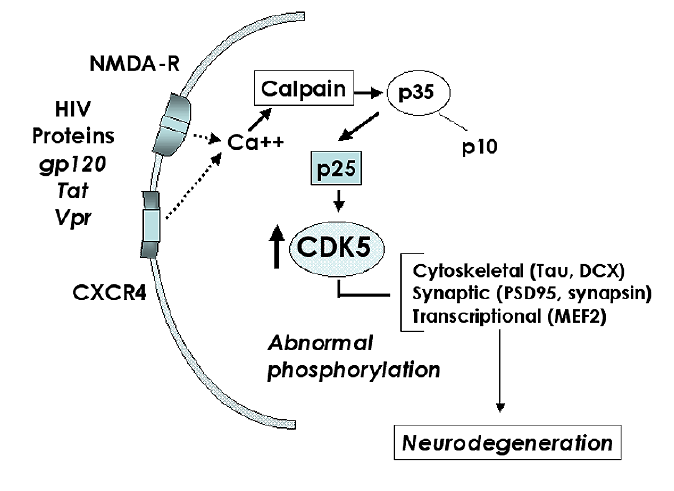
Figure 6. Potential mechanisms of HIV-induced neurodegeneration mediated by hyperactivation of CDK5. Activation of cell surface receptors by HIV proteins or cellular neurotoxins causes calcium influx, which might activate calpain and result in p35 cleavage into p25, which in turn hyperactivates CDK5. This leads to aberrant phosphorylation of CDK5 substrates involved in synaptic plasticity (PSD95, synapsin) and neurogenesis (DCX). Alterations in these critical functions might contribute to the underlying neurodegenerative process of